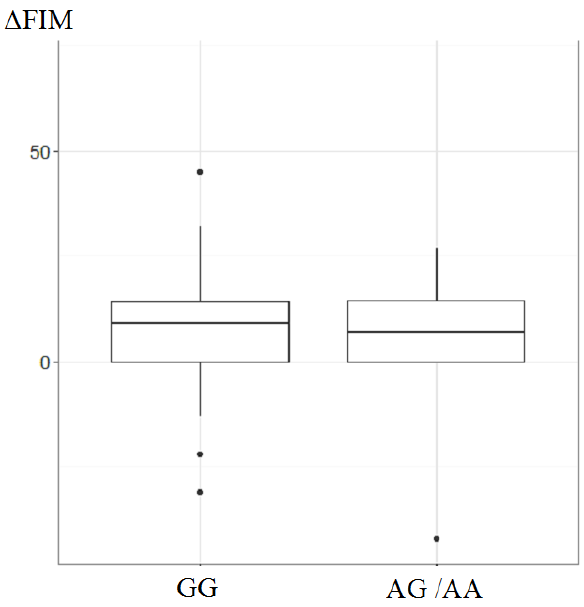
Figure 1. The relationship of the XRCC1 rs25487 variant to the short-term functional outcome.